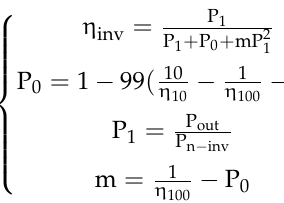
Fig. 8. T he proposed fi ve-phase PM SG based M C T control schem e. L oss com pensation ˆ e abcde ( ✓ e )back-E M F estim ation ˆ ✓ e ˆ e abcde ( ✓ e ) ˆ ! r R eference current calculation i ⇤ abcde Fault detectioni abcde Fig. 9. Schem e of the adaptive strategy to determ ine reference currents. III. C O N T R O L S T R A T E G Y T he proposed controlstrategy is illustrated in Fig.8.T he PI algorithm is used to control the rotor speed w ith its reference generated by the M PPT algorithm . T he fi ve-phase PM SG currents are controlled by FC S-M PC approach. T he detailed control algorithm s are described as follow s: A.ReferenceSpeedCalculation T he reference speed is calculated from the m arine current speed by the conventional M PPT algorithm : ! ⇤ r = λ opt V R (10)